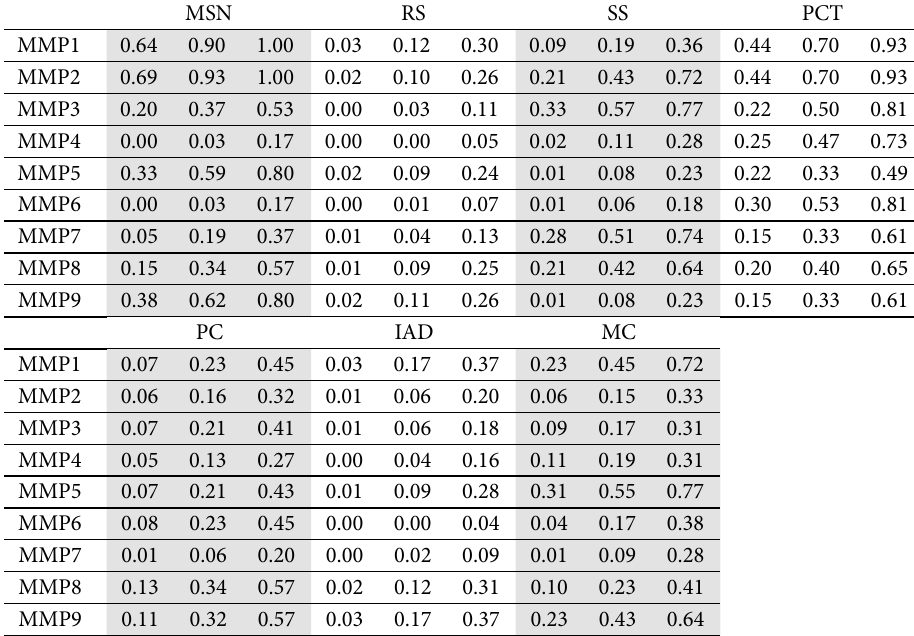
Table 11. The fuzzy weighted normalized decision